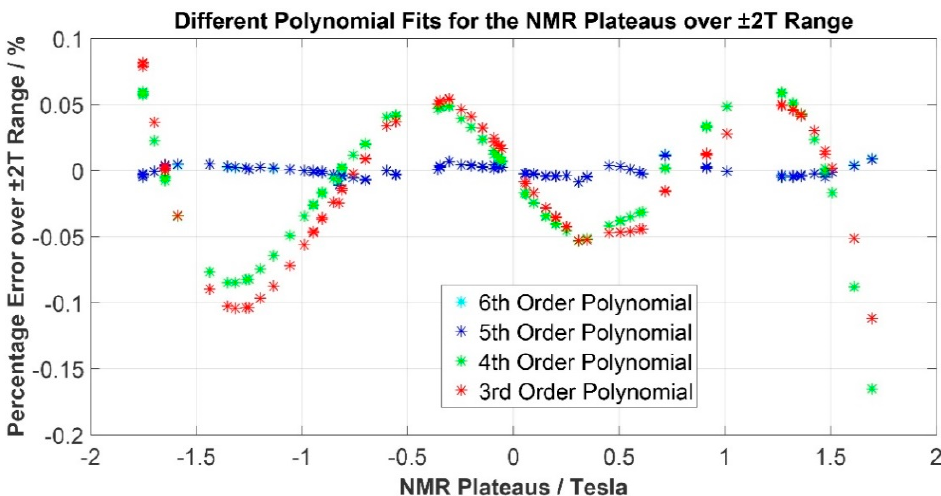
Figure 5. The application of 3rd order to 6th order polynomial fits in modelling the nonlinear relation between the instrument output and the nuclear magnetic resonance (NMR) values. The resulting percentage error is shown for each polynomial fit.